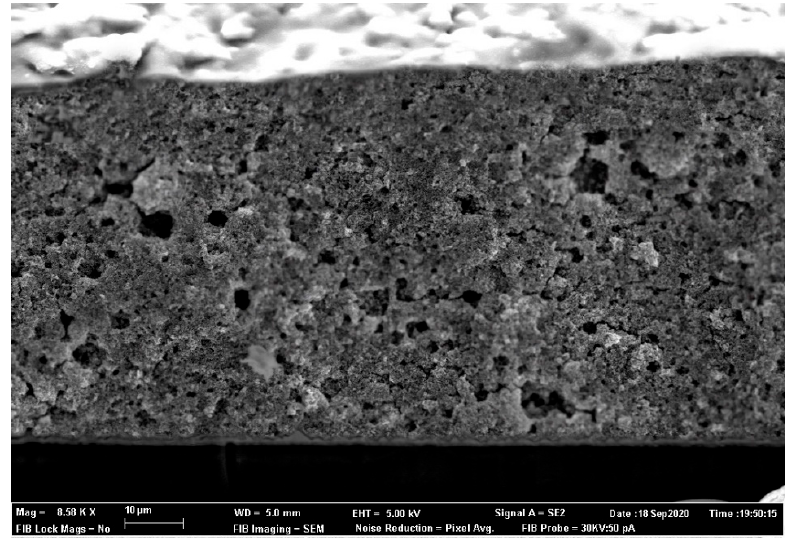
Figure 5. FESEM image of the fibbed cross ‐ section of the ZnO ‐ B sample where the approximately 60 μ m thick layer is observed over the FTO layer.